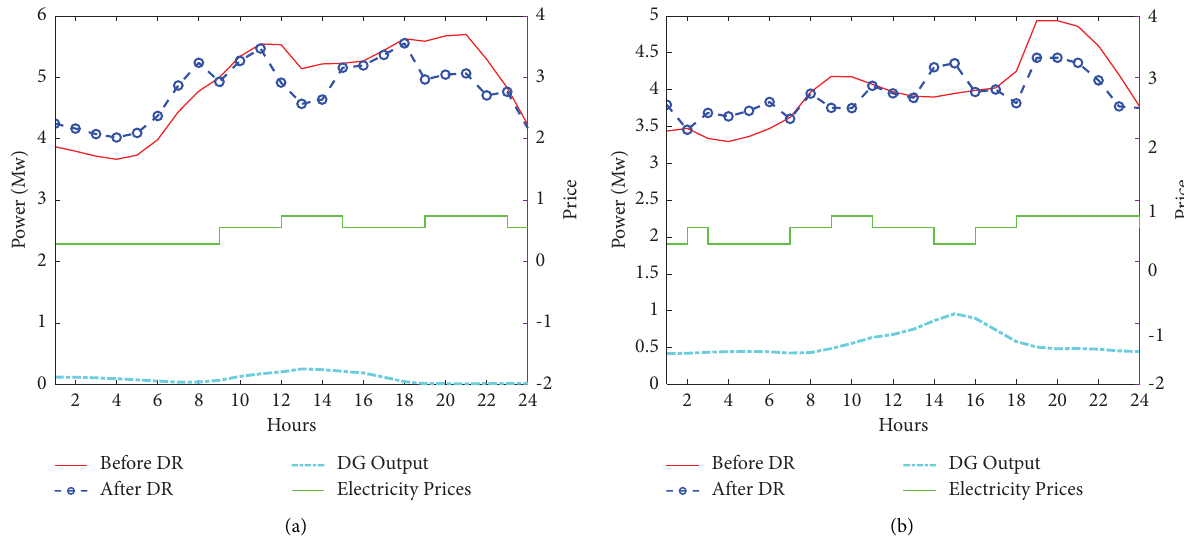
Figure 8: Classifcation of the TOU price. (a) Change of electricity price, load, and DG output in the scenario with fxed TOU price. (b) Change of electricity price, load, and DG output in the scenario with dynamic TOU price.